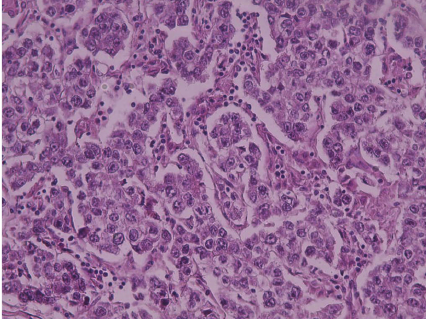
Figure 5: Higher magnification showing focal prominent nucleoli of the tumor cells ( × 20; H&E stain).